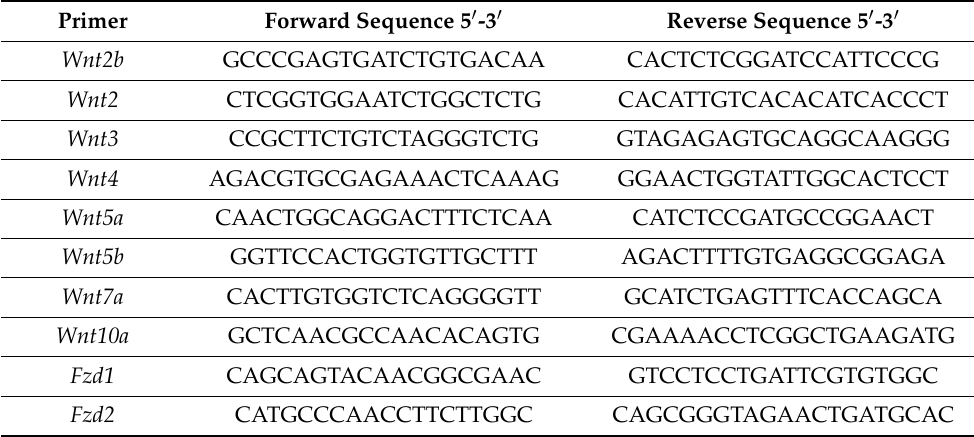
Table 1. List of mouse primer sequences used for